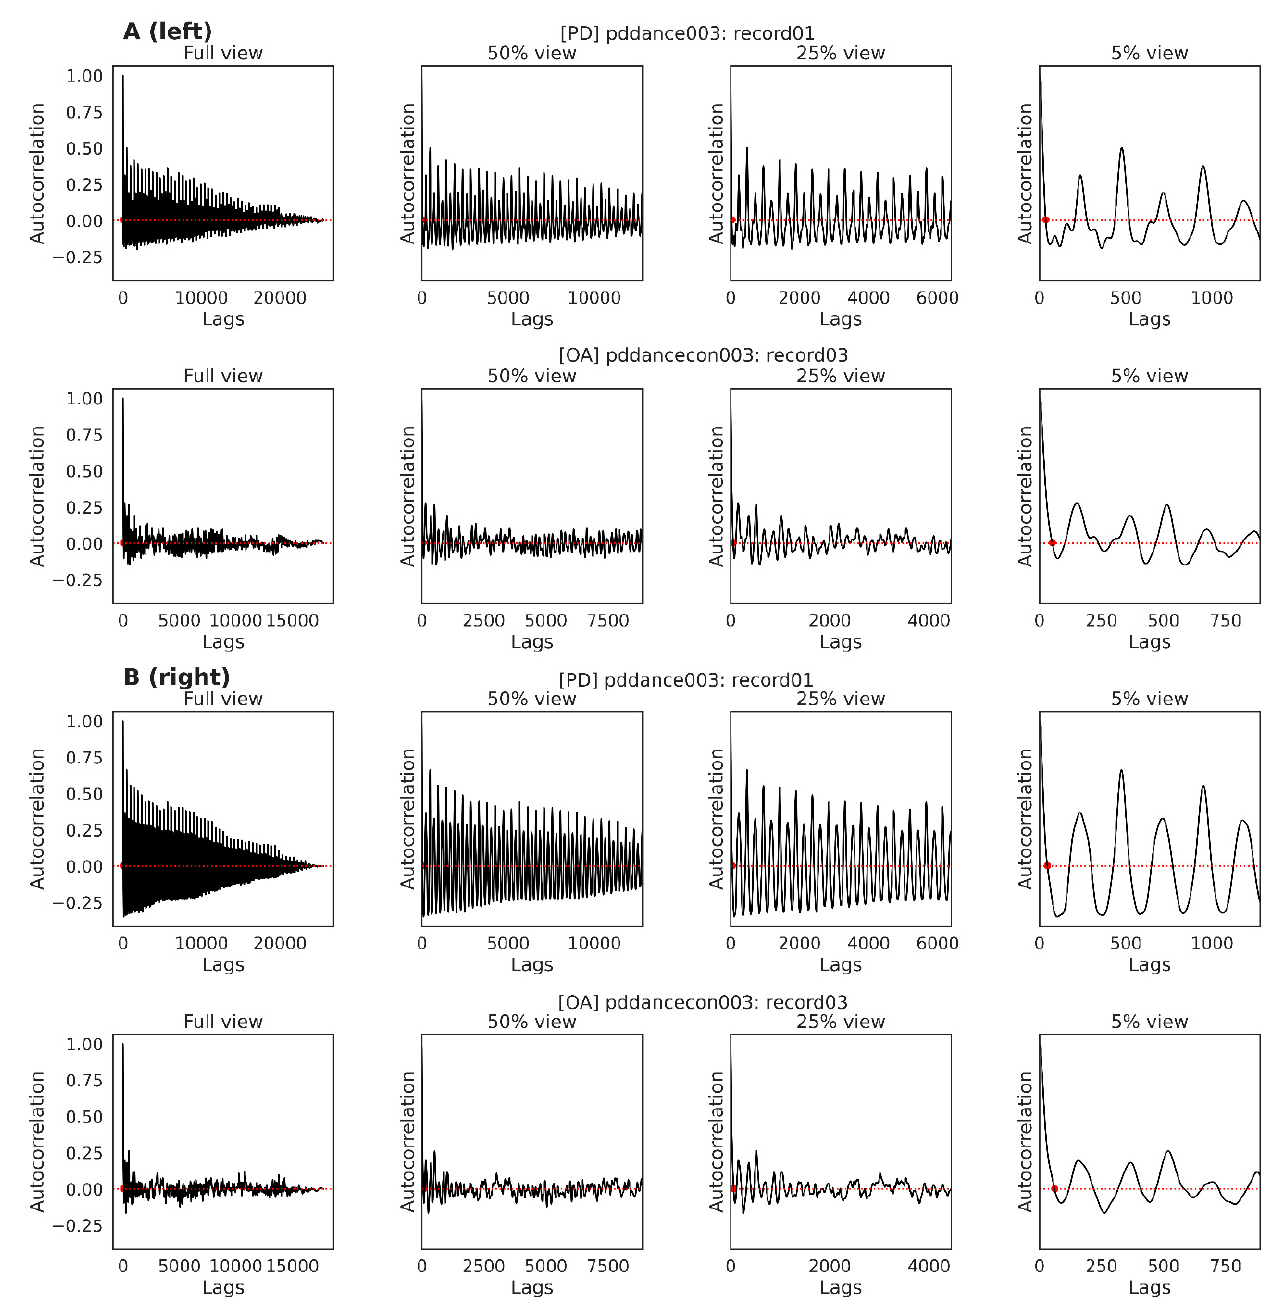
Figure 5. Left and right knee flexion during tango . Demonstrating ACF plots of left ( A ) and right ( B ) knee flexion for one PD and one OA participant. Red dot represents the selected lag value (smallest lag value where the ACF is closest to 0). The graph represents correlations of a time series with a lagged version itself. A lag of 1 indicates correlating time series with itself, which will be perfect correlation. Lag of 2 indicates correlating time series with a version of itself that was shifted to the right by one time unit. Possible number of time units is the length of the time series.